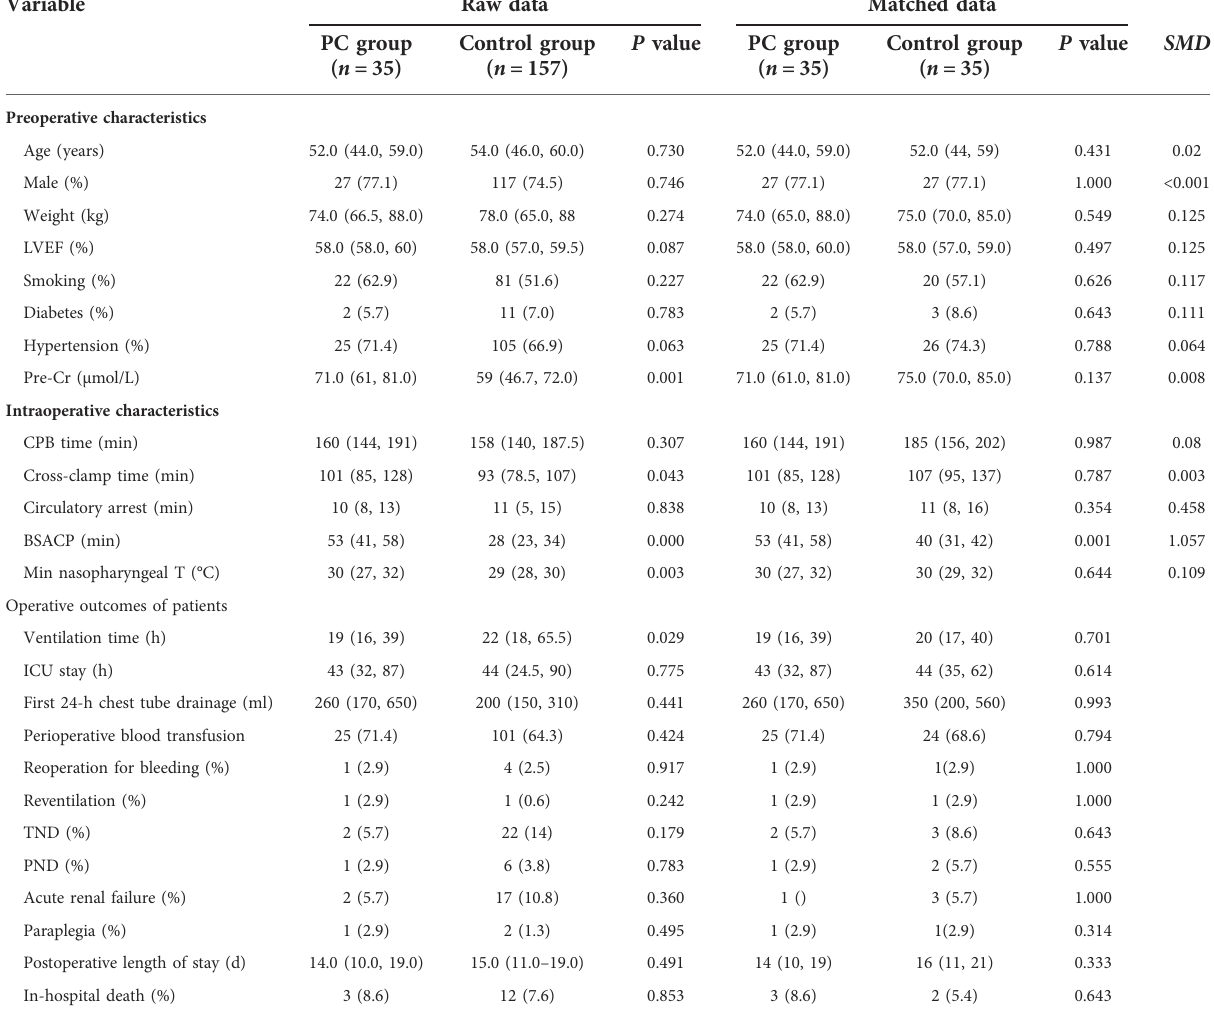
TABLE 1 Perioperative characteristics of patients. Variable Raw